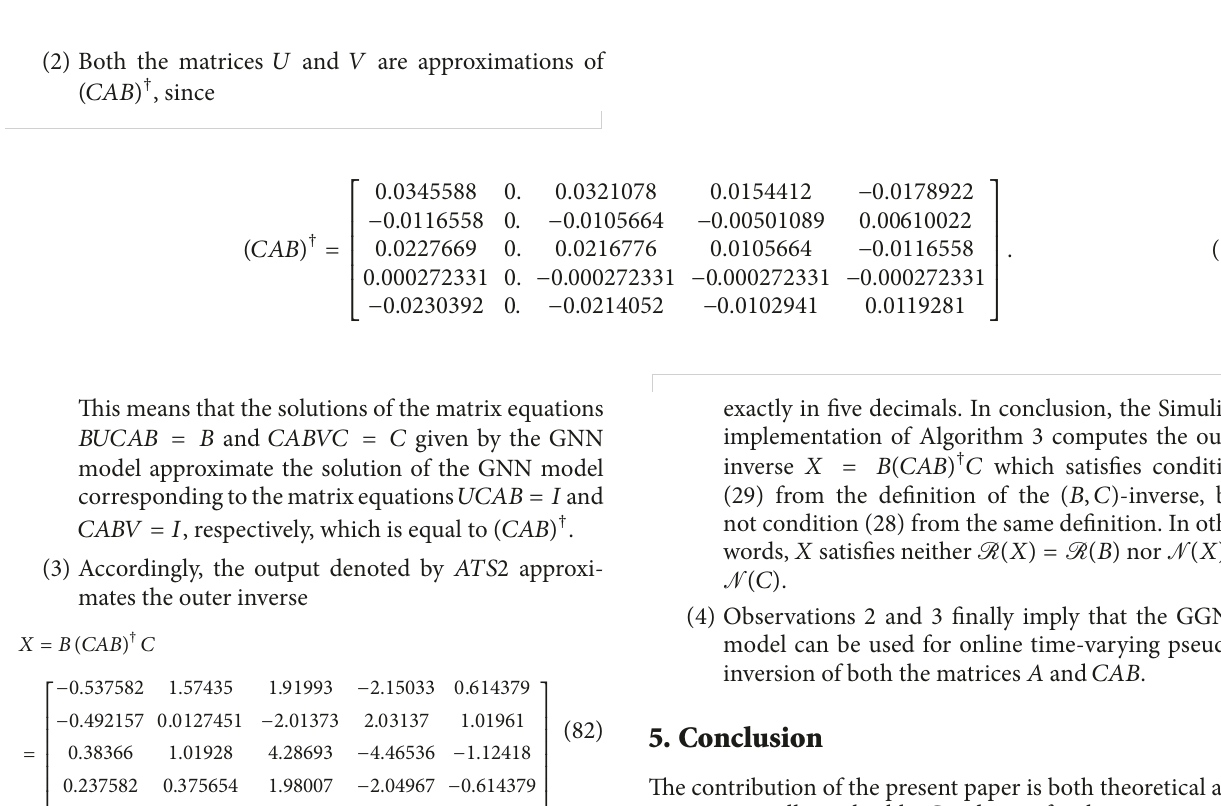
Figure 12: The Simulink model for computing 𝐵(𝑡)(𝐶(𝑡)𝑆 5 (𝑡)𝐵(𝑡)) (1) 𝐶(𝑡)